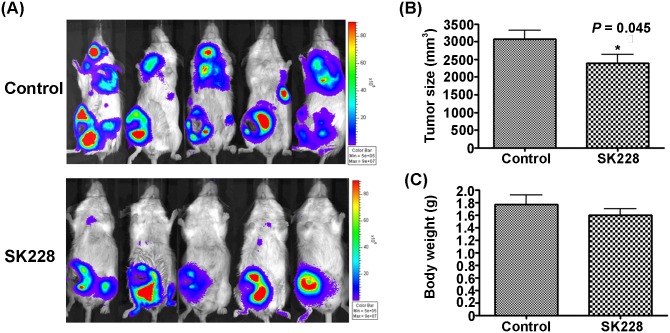
SK228 inhibits the growth of 4T1-Luc xenografts and consequently delays cancer cell metastasis via reversal of EMT process and miR-200c/ZEB1/E-cadherin signaling pathway.(A) BALB/c mice bearing the established 4T1-Luc tumors (50 mm3) are treated with SK228 (12.5 mg/kg/mouse/week) via intraperitoneal injection on the first 3 days in the first week, then two shots on day 1 and day 4 at a dose of 6.25 mg/kg/week for another 3 weeks (final dose = 50 mg/kg/mouse), or vehicle (30% PEG400+70% PBS) control. The results of spontaneous metastasis assays show that SK228 treatment delays cancer cell metastasis in animal models. (B) The tumor size indicated in the graph represents the measurement of the primary tumor only. Tumor volumes, measured every other day until day 28, are expressed as mean ± SD; *P = 0.045. (C) The average body weight between vehicle and SK228 groups is not significantly different.